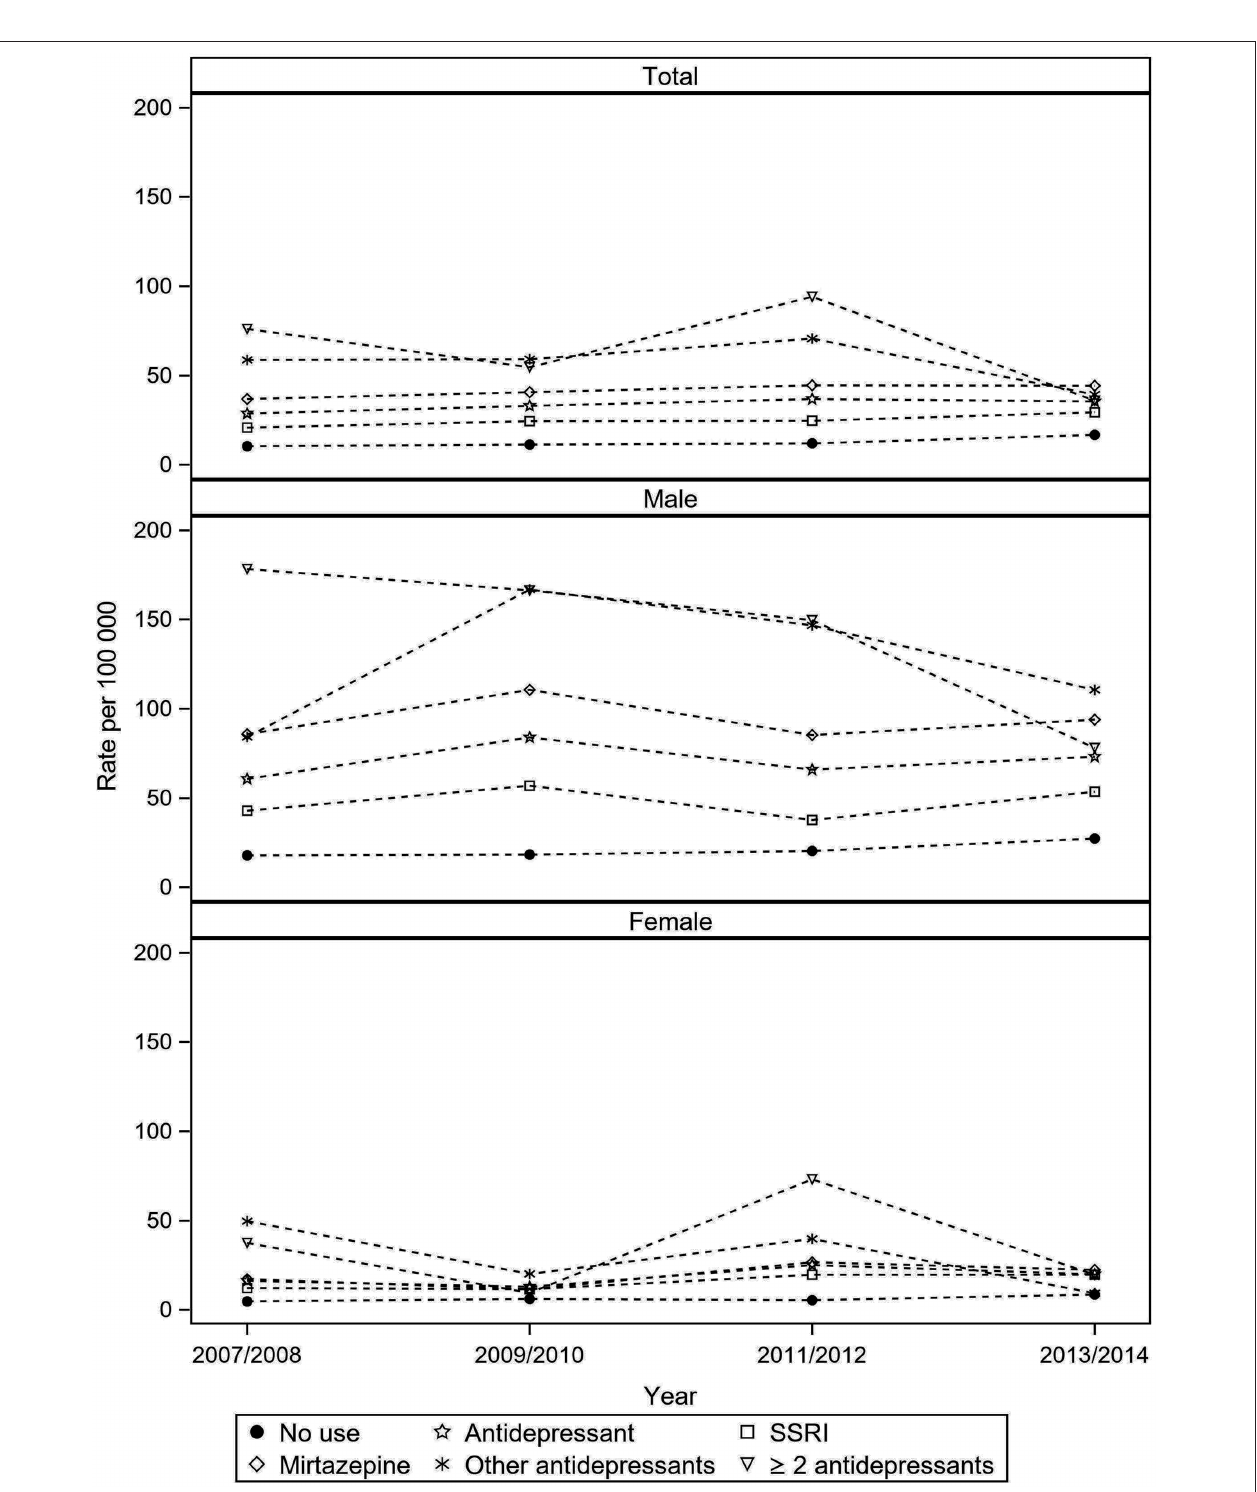
FIGURE 1 | Biannual suicide rate by in antidepressant users and non-users among residents aged 75 and above in Sweden from 2007 to 2014 a . a Excluding users of tricyclic antidepressants with no other antidepressant prescription ( N = 46,244).